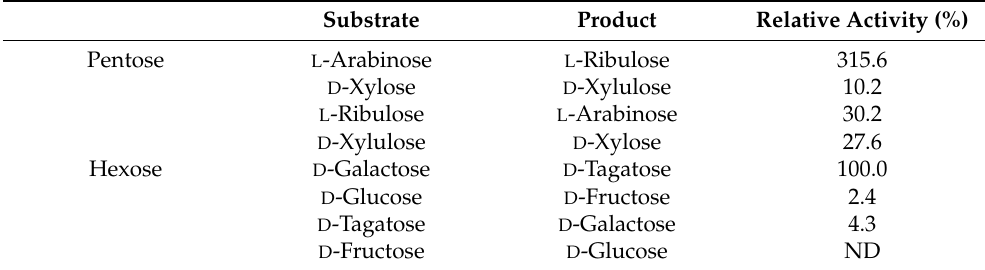
Table 2. Substrate specificity of L -arabinose isomerase from K. pneumoniae